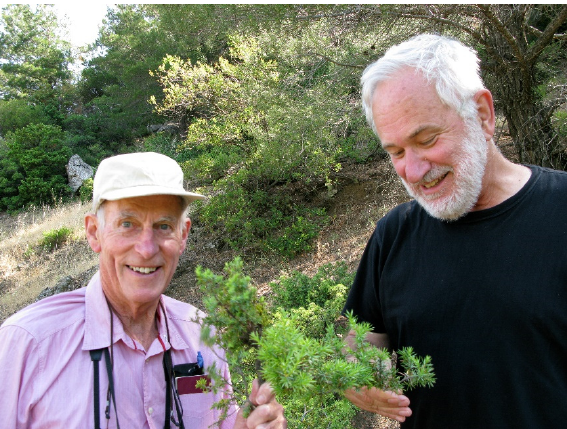
Figure 3. Chris P. and Lytton M. hunting for Arceuthobium oxycedri on Mt Sypilos in Turkey 2009.